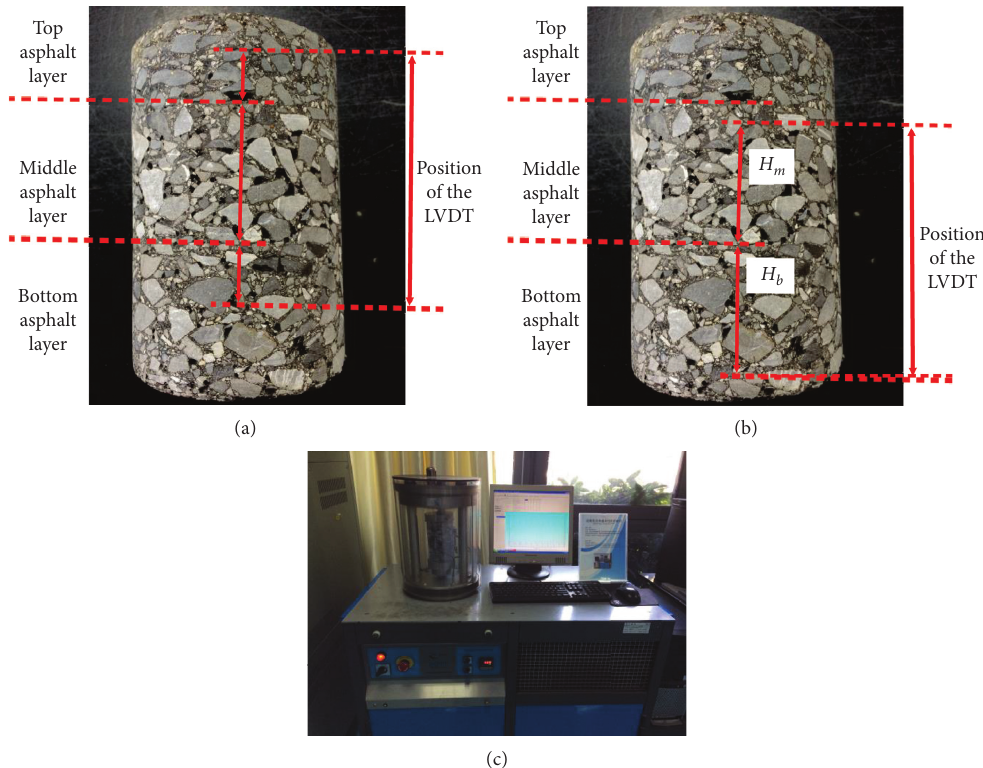
Figure 6: Dynamic modulus test: (a) location of the LVDTs for E-9-1, E-9-2, and E-9-3; (b) location of the LVDTs for E-10-1 and E-10-2; (c) test